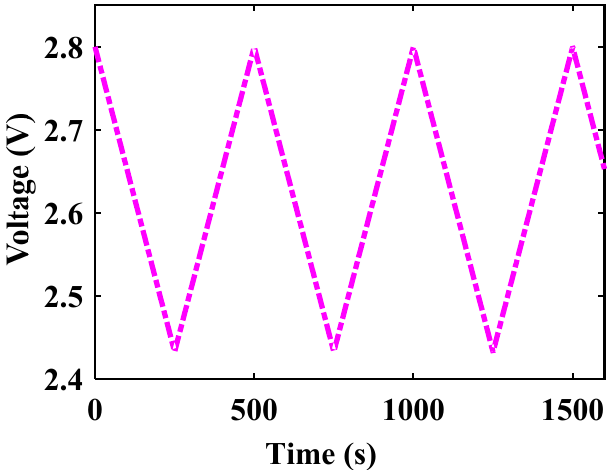
Figure 8. Change in terminal voltage of UC during charging/discharging.